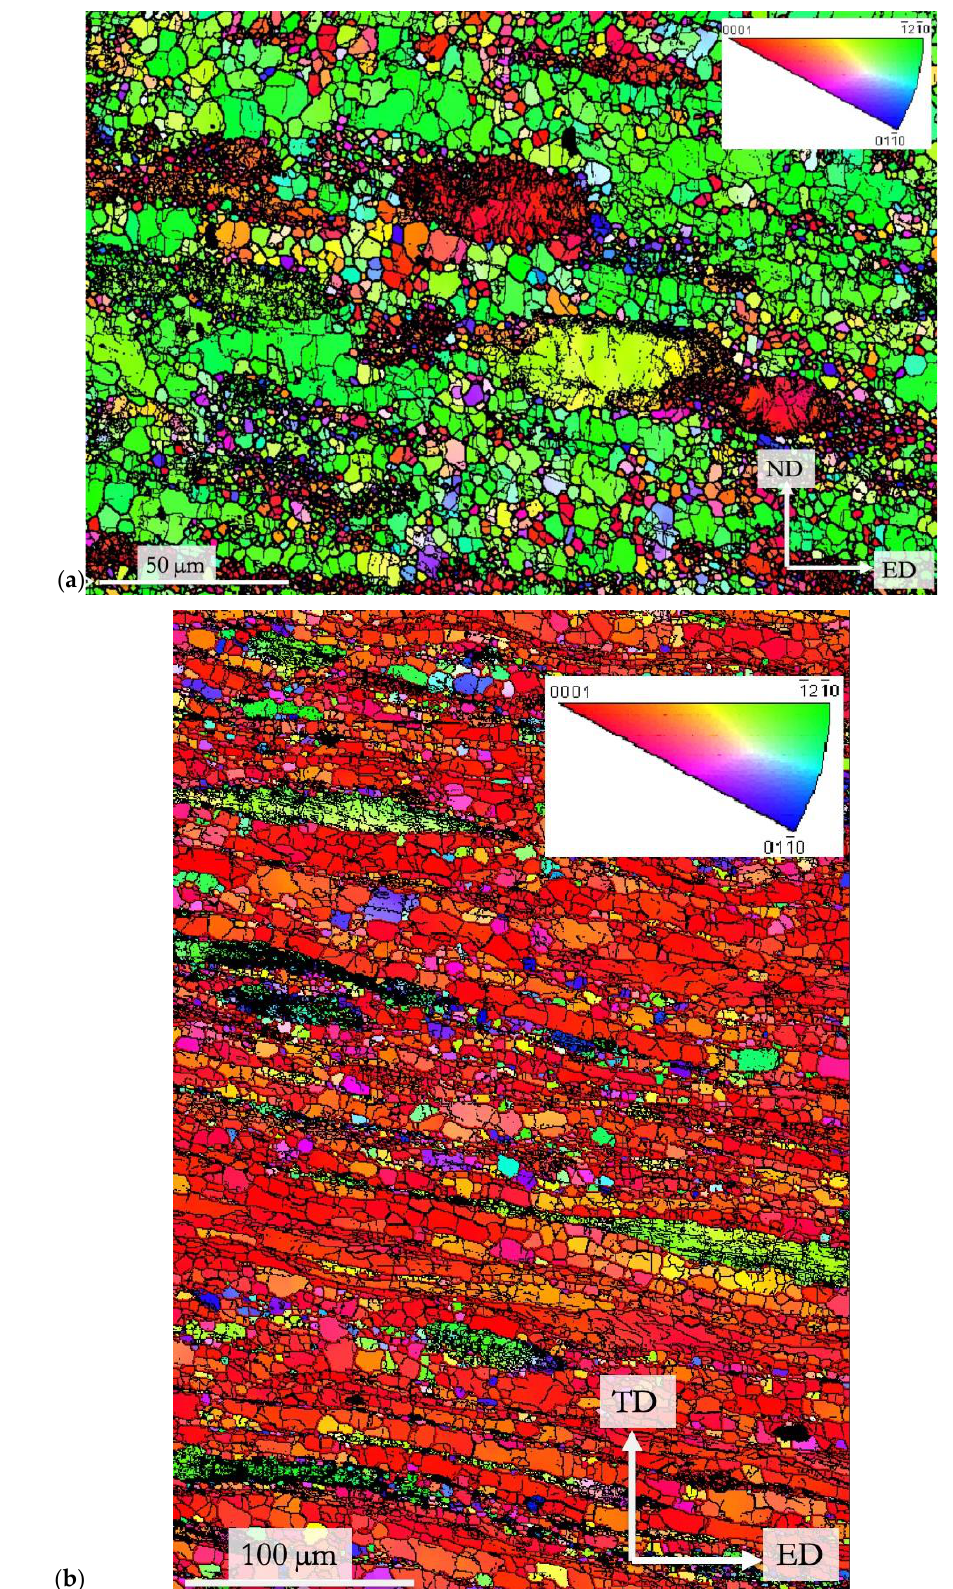
Figure 2. EBSD microstructures of the as-received ZK60A-T5 alloy plate on ( a ) ED-ND and ( b ) ED- transverse direction (TD) planes. The extrusion direction is horizontal.